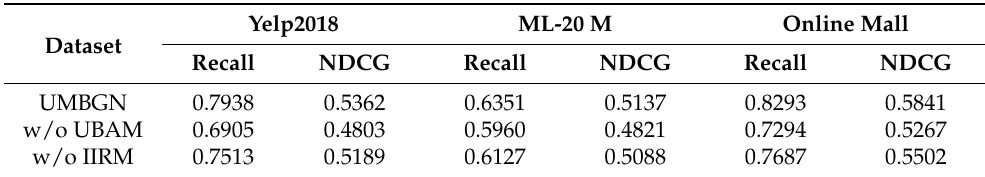
Table 4. Performance of user multi-behavior awareness module and item information relation module.